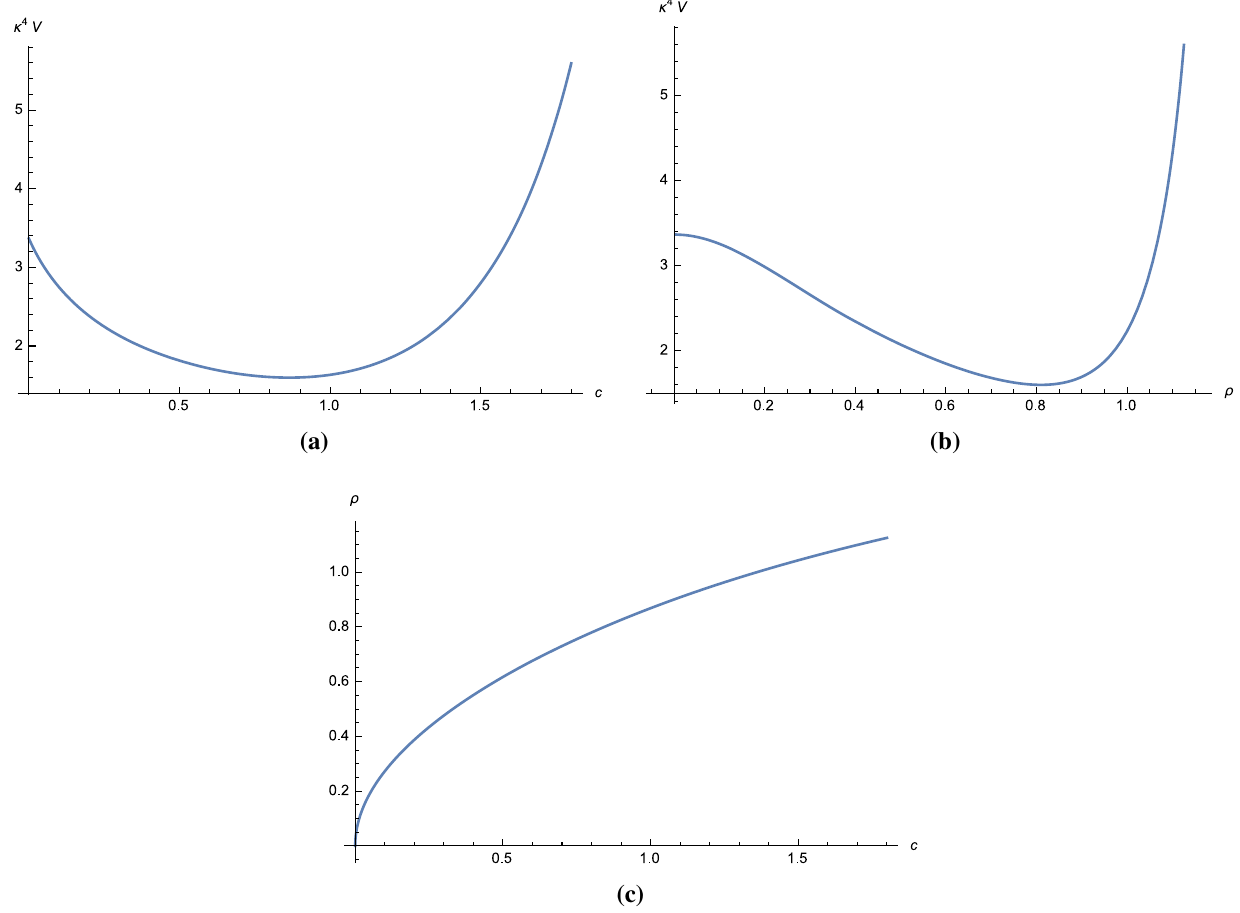
Fig. 5 The scalar potential for a model in Region IV of Fig. 1 with parameters chosen in (5.35) is plotted as a function of c and ρ coordinates in a , b , respectively. Plot in c shows the relation between ρ and c